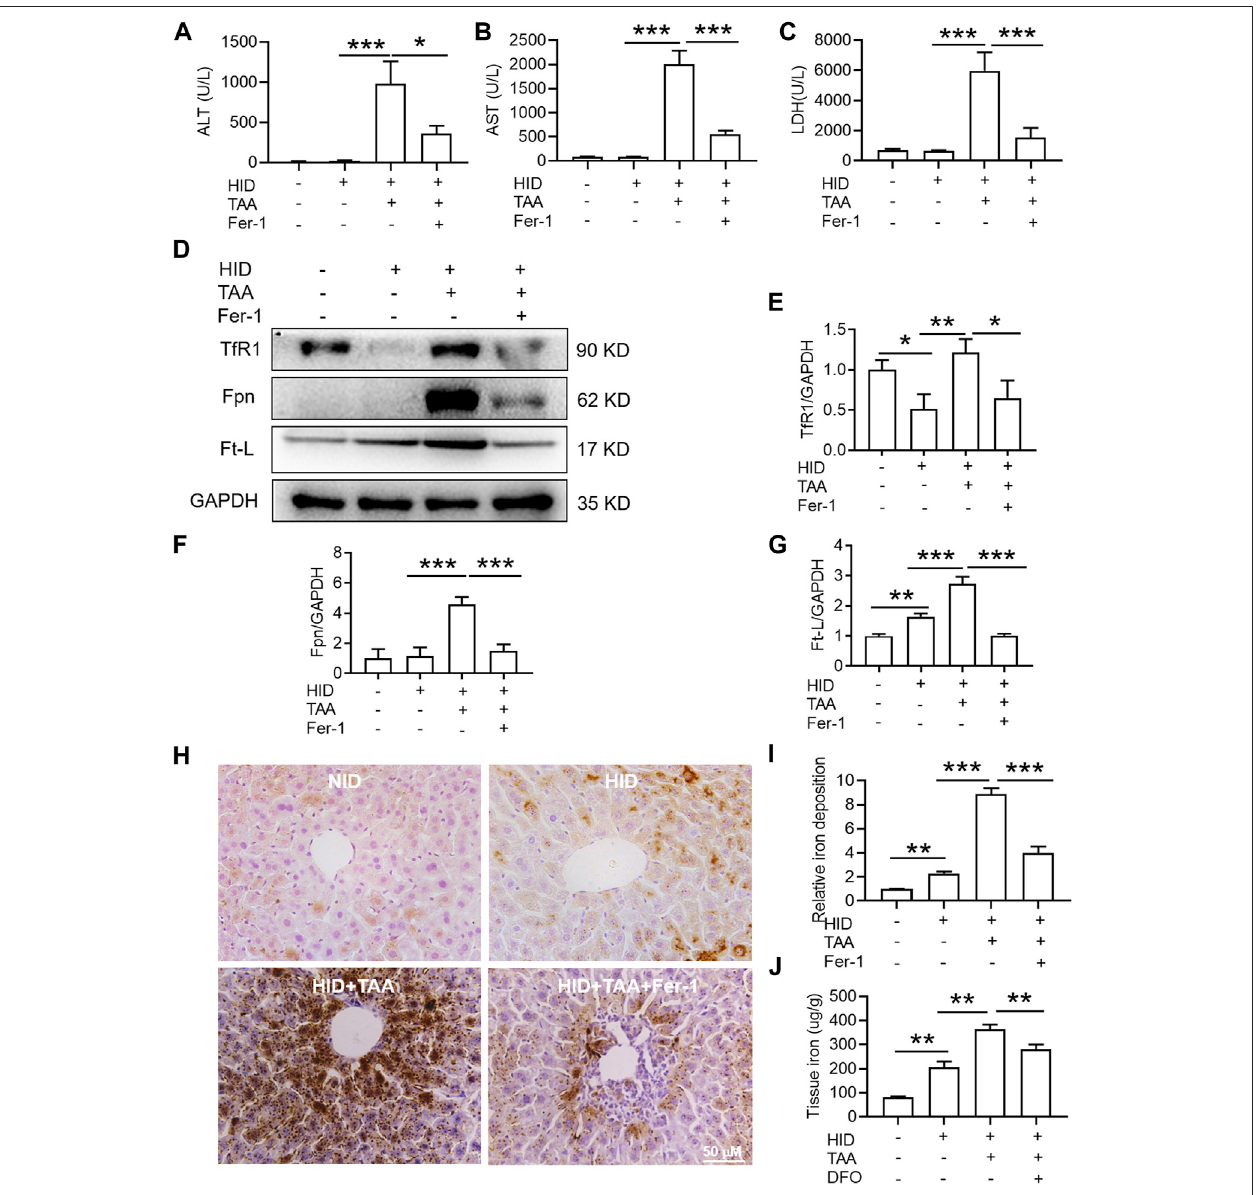
FIGURE 6 | Effects of Fer-1 on liver function, hepatic iron content and anti-ferroptosis-related protein expression in the liver under iron overload conditions. (A) PlasmaALT (B) ASTand (C) LDHlevelsinthecontrolandTAAmodelmicewithorwithoutFer-1pre-treatmentunderhighirondiet(HID)conditions. (D) Westernblotting analysis of TfR1, Fpn and Ft-L expression in the livers of mice with different treatments under HID conditions. (E – G) Relative protein expression of TfR1, Fpn and Ft-L in (D) (H) Fer-1 inhibited the increase in positive centrolobular iron deposition induced by TAA under HID conditions in the liver. (I) Semiquantitative analysis of iron deposition levels in (H) (J) Iron content detection in the livers of mice with different treatments. All data are presented as the mean ± SEM ( n = 6-9 mice per group); * p < 0.05, ** p < 0.01, and *** p < 0.001 versus the indicated group.